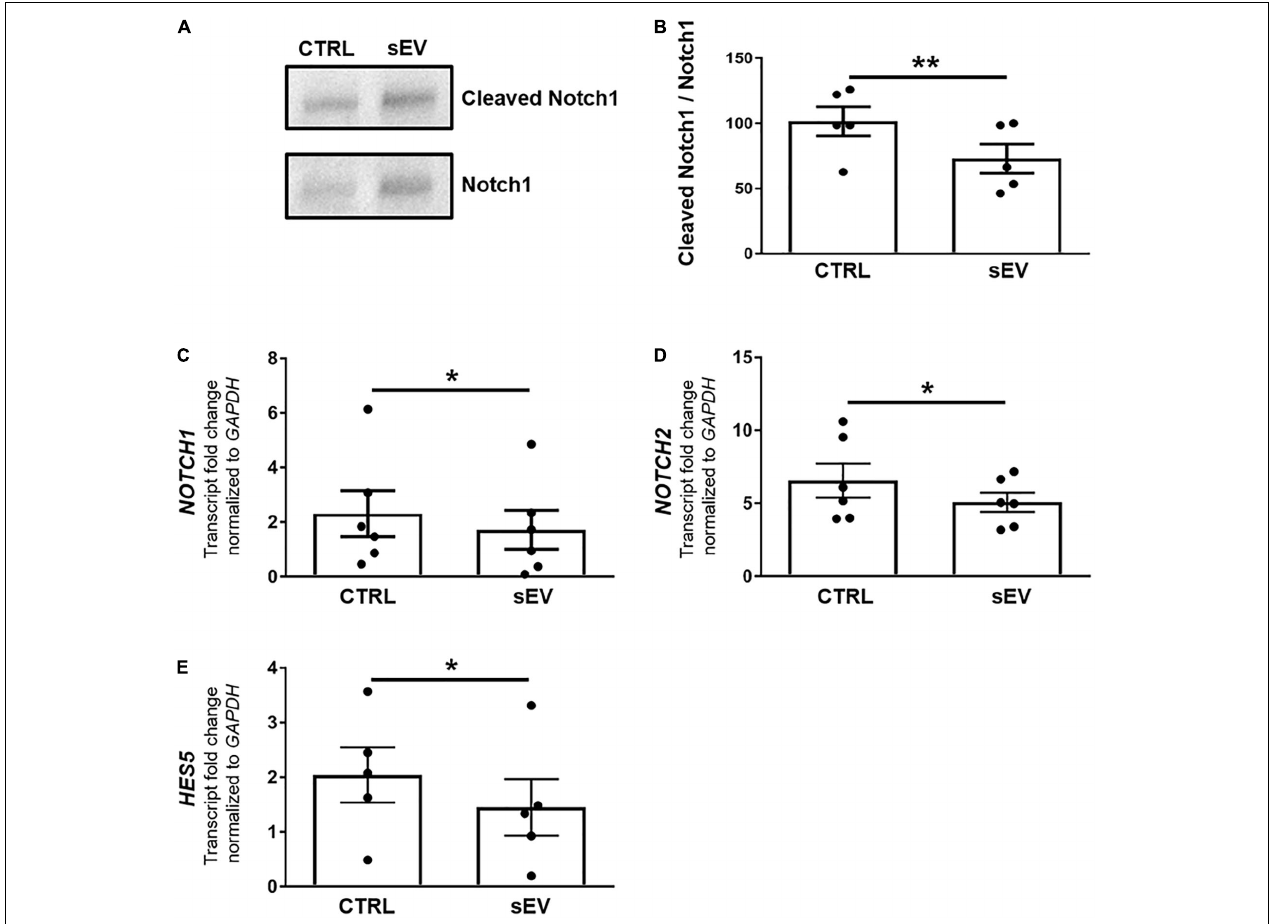
FIGURE 2 | WJ-MSC-derived sEV drive oligodendrocyte maturation in MO3.13 cells by reducing Notch signaling. (A) Representative western blot of Notch1 and Cleaved Notch1 (NICD) levels in MO3.13 cells either left untreated or co-cultured with 0.5 µ g/mL sEV for 5 days. (B) Quantification of the Notch1/NICD ratio ( n = 5). (C–E) Transcription of NOTCH1 ( n = 6), NOTCH2 ( n = 6), and HES5 ( n = 5) by MO3.13 cells either left untreated or co-cultured with 0.5 µ g/mL sEV for 5 days. Data are presented as mean ± SEM. * p < 0.05, ** p <